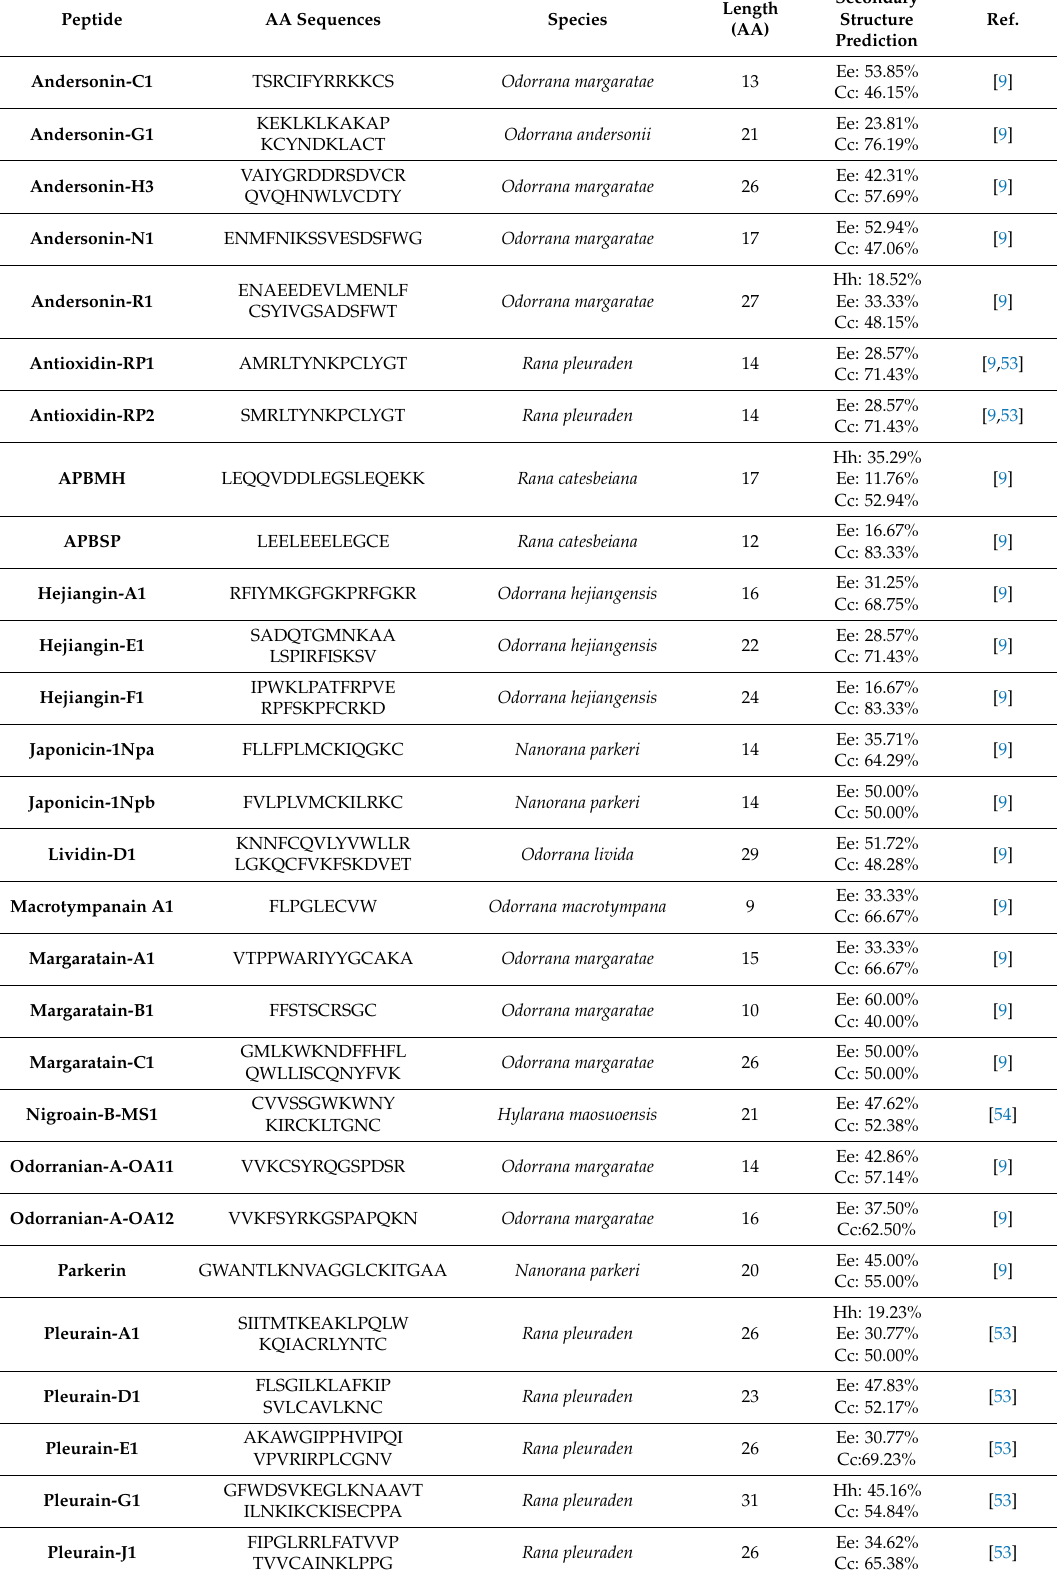
Table 2. Antioxidant peptides relevant for amphibian skin defense. Secondary structure prediction was performed by the GOR IV algorithm